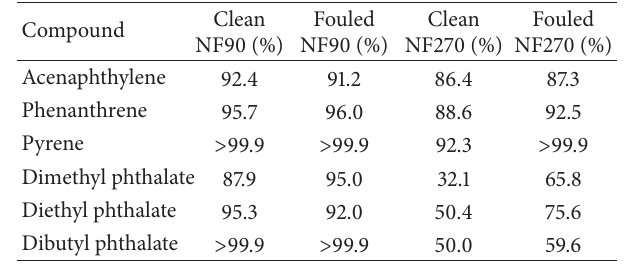
Table 3: Rejection of organic micropollutants by NF90 and NF270.